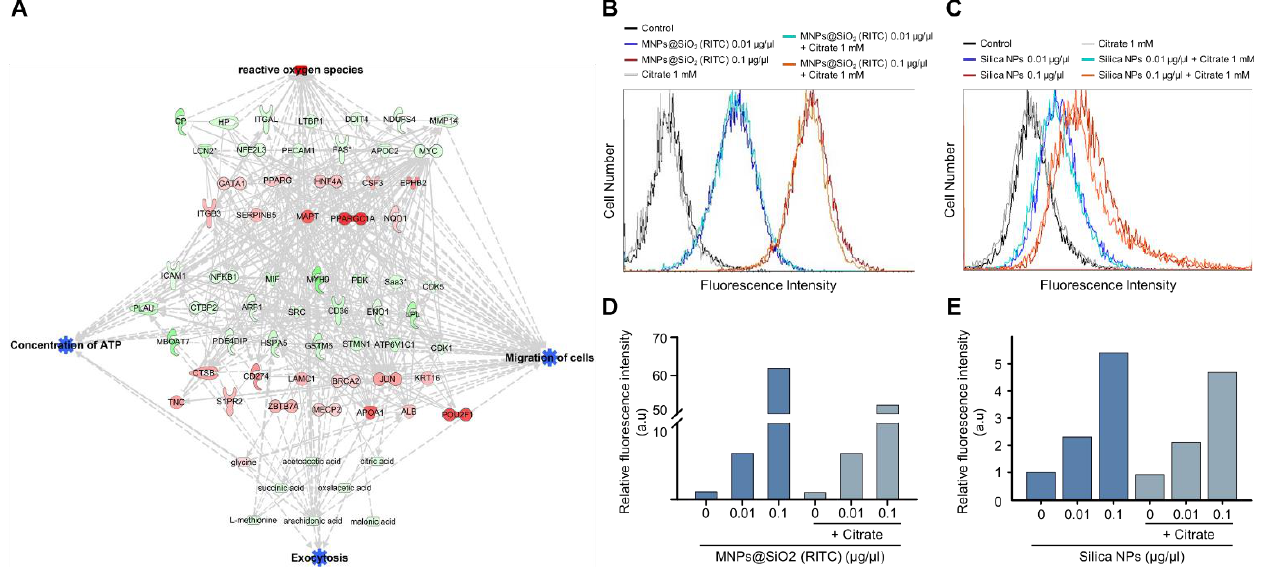
Figure 7. Induction of exocytosis in MNPs@SiO 2 (RITC)- and silica NP-treated BV2 cells by citrate treatment. ( A ) Trimmed using machine learning algorithm triple-omics network with the prediction of 0.1 µg/µL MNPs@SiO 2 (RITC)-treated BV2 cells including exocytosis. Top group: transcriptome, middle group: proteome, bottom group: metabolome. Symbols are described in the legend of Figure S2. Orange and blue areas indicate the prediction as activation and inhibition, respectively. FACS analysis for evaluation of fluorescence of ( B ) MNPs@SiO 2 (RITC) and ( C ) silica NP-treated BV2 cells in the presence of 1 mM citrate. Relative fluorescence intensity of ( D ) MNPs@SiO 2 (RITC) and ( E ) silica NPs in BV2 cells. a.u.: arbitrary unit.